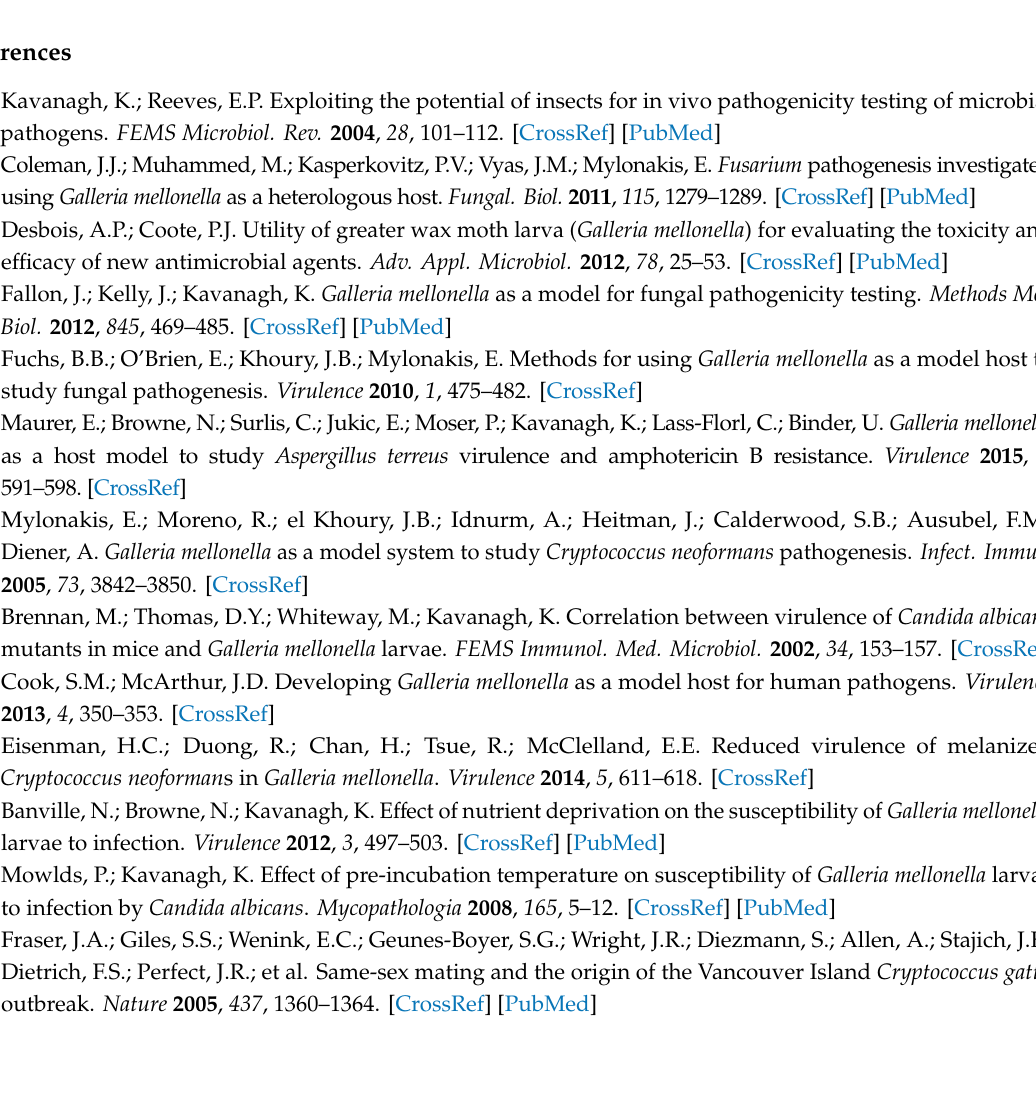
Table S1: Equipment and average cost involved in propagating Galleria mellonella in the